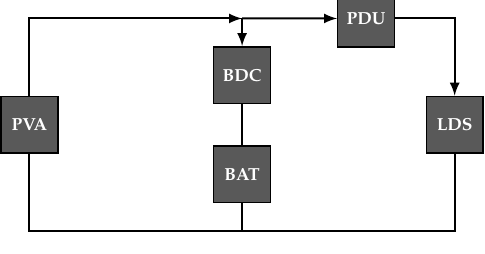
Figure 2. Proposed FRDET